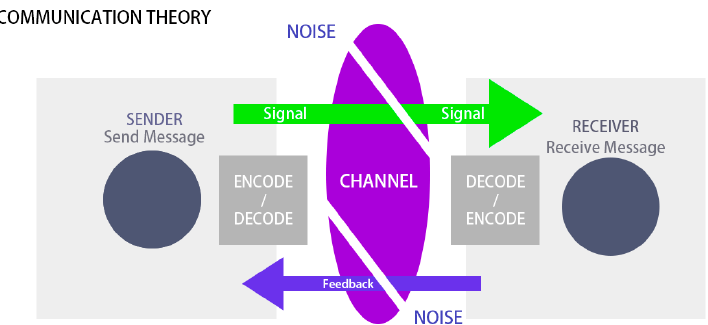
Figure 1. Communication Theory, by Shannon [26]. The elements depicted in Communication Theory may be a basis for designing interactive systems, such as VR and immersive environments and video-games. Communication Theory has also contributed to developing subsequent theories and approaches, such as the “bidirectional communication theory” [27], and has had a strong influence on approaches such as interaction design and human factors, among others.